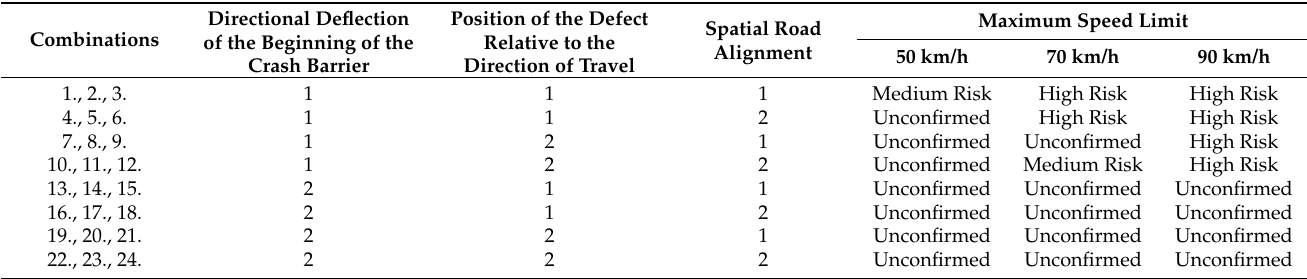
Table 12. Hypothesis II.—Incorrect beginning/end of the crash barrier.